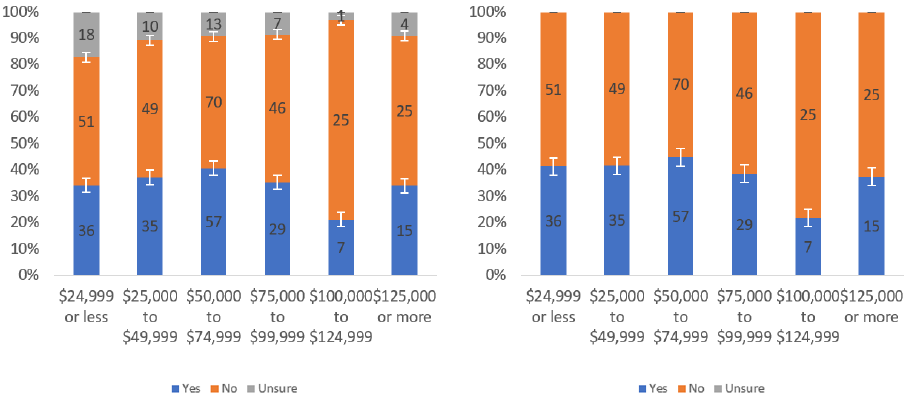
Figure 26. Responses regarding label annoyingness by income level including ( left ) and excluding ( right ) unsure responses.